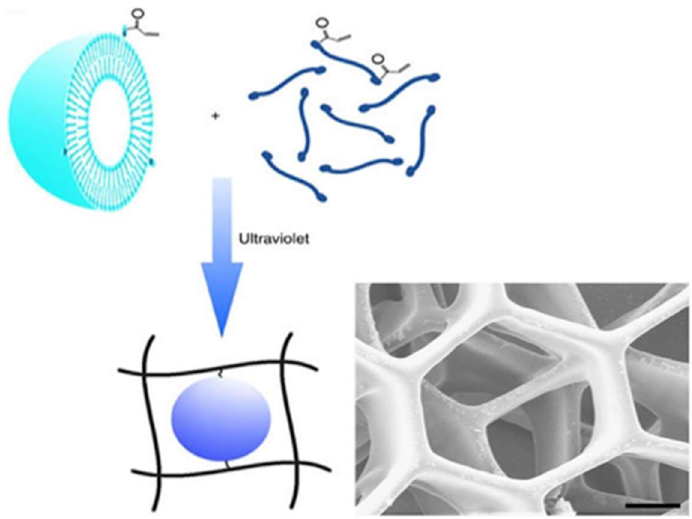
Figure 5. Schematic presentation of installing PDA nanoparticles in the network of hydrogels and scanning electron microscope image of the nanogel detoxifier (modified from [62]).